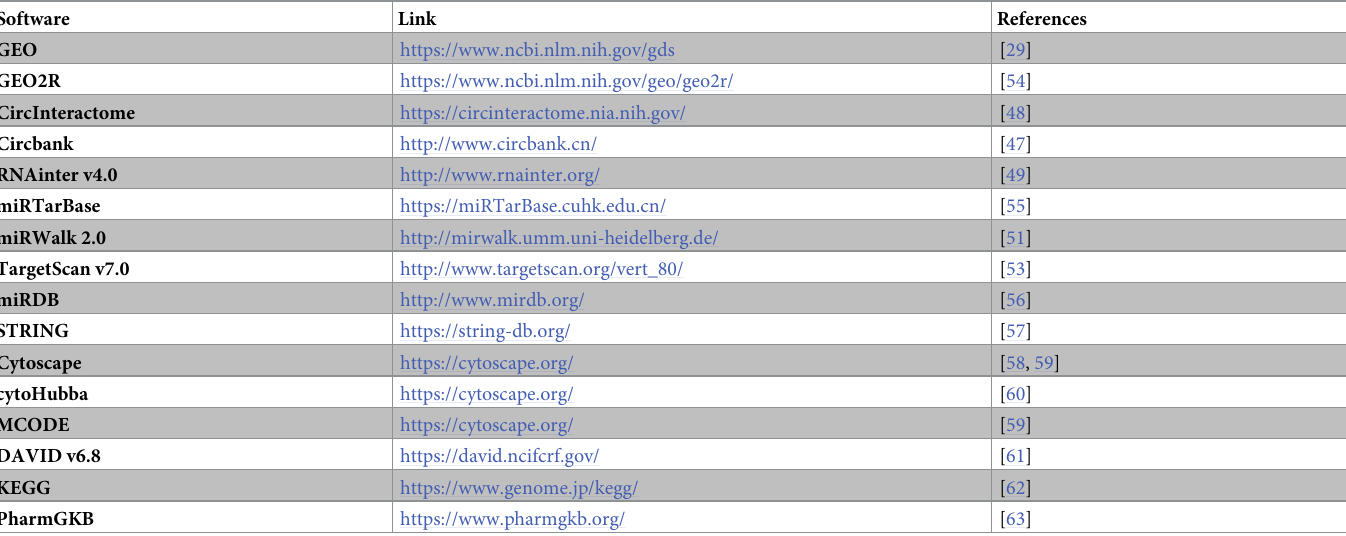
Table 2. List of all softwares and tools utilized in the current study.